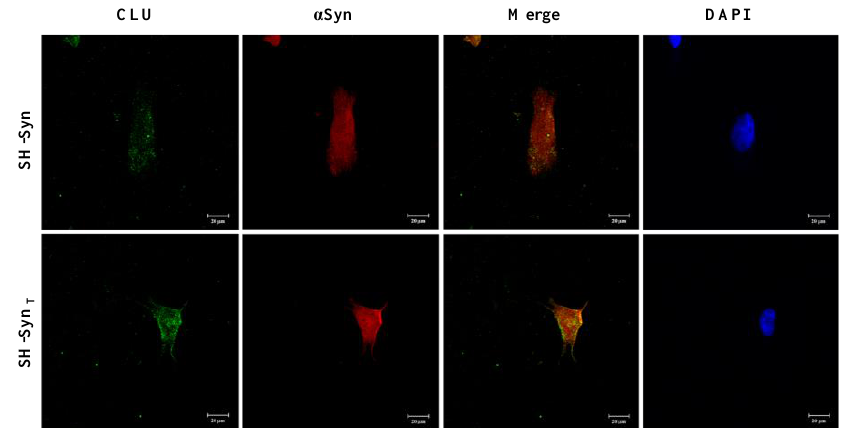
Figure 6. Localization of CLU and α Syn in SH-Syn and SH-Syn T . Representative images of the intracellular localization of CLU (green fluorescence) and α Syn (red fluorescence) in SH-Syn and SH-Syn T acquired by confocal microscopy. Cell nuclei were stained with 4′dye-6-diamidino-2-phenylindole (DAPI, blue fluorescence). Magnification 40×.